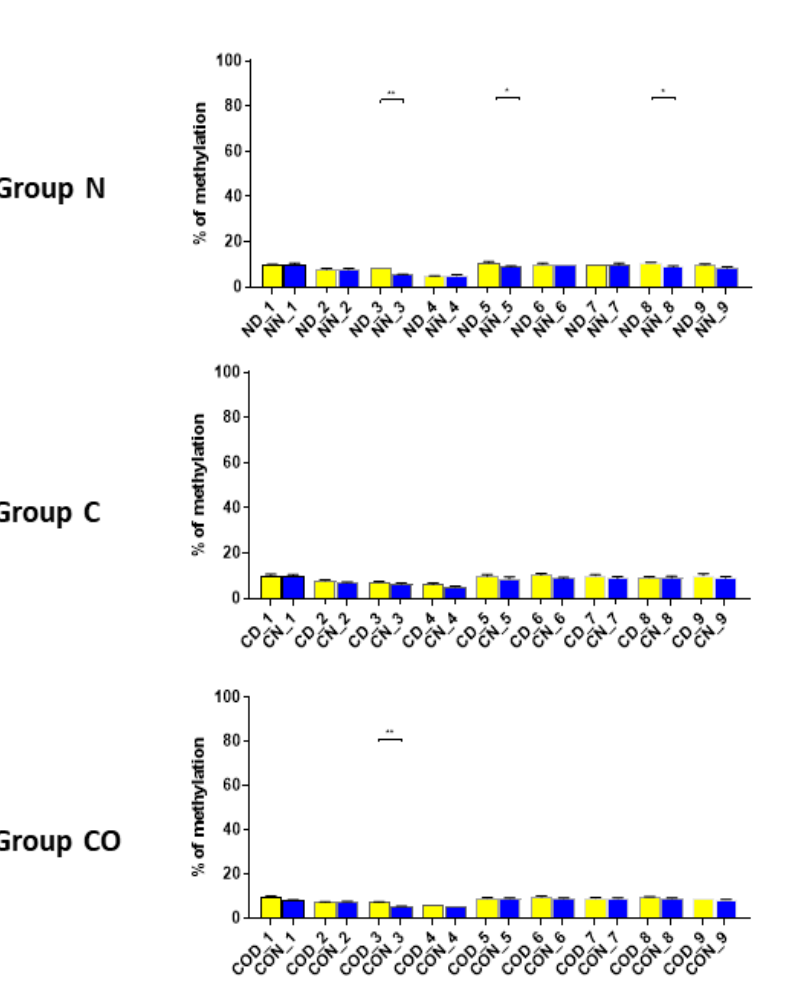
Figure 2. The difference between day (yellow bar) and night (blue bar) methylation levels in the hypothalamus in the normal (N), control (C) and CO-treated groups. The region closest to the ATG ( − 1– − 79 bp) canonical E-box was hypomethylated. In this region, the difference between methylation was observed in the normal group at the 3rd, 5th and 8th CpG positions. The CO-treated group showed a significant change in the methylation level in the 3rd CpG position. The bars are represented as mean ± SEM. The asterisks indicate significant differences as follows: *— p < 0.05; **— p < 0.01. At the top of the figure is the examined sequence: original ( top ) with yellow highlighted sequences E-box and D-box and bisulfite converted with highlighted methylation position ( bottom ).